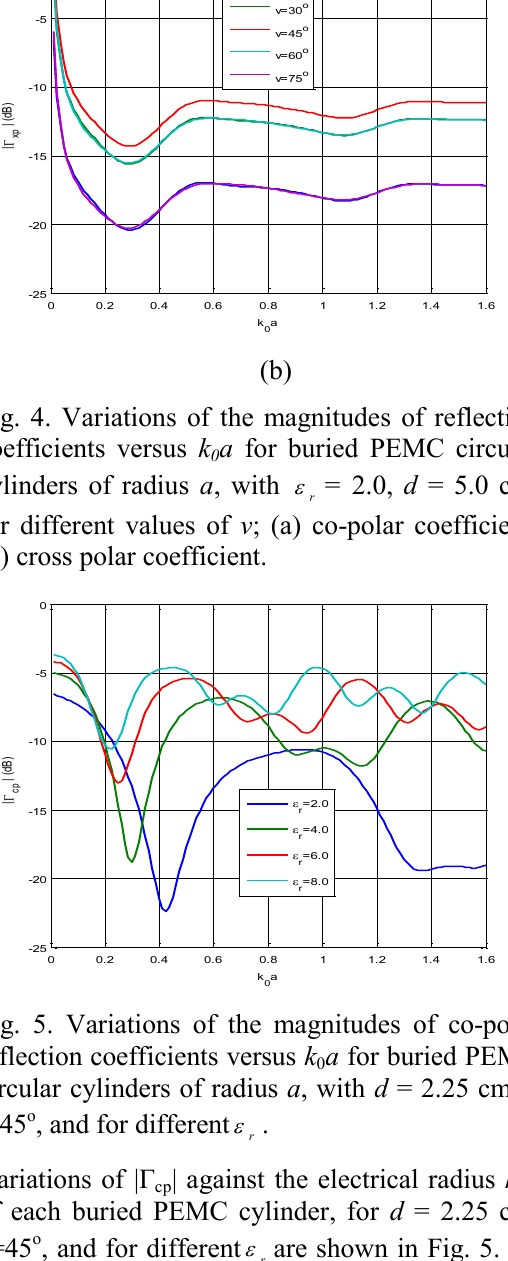
a for buried PEMC 0  . r